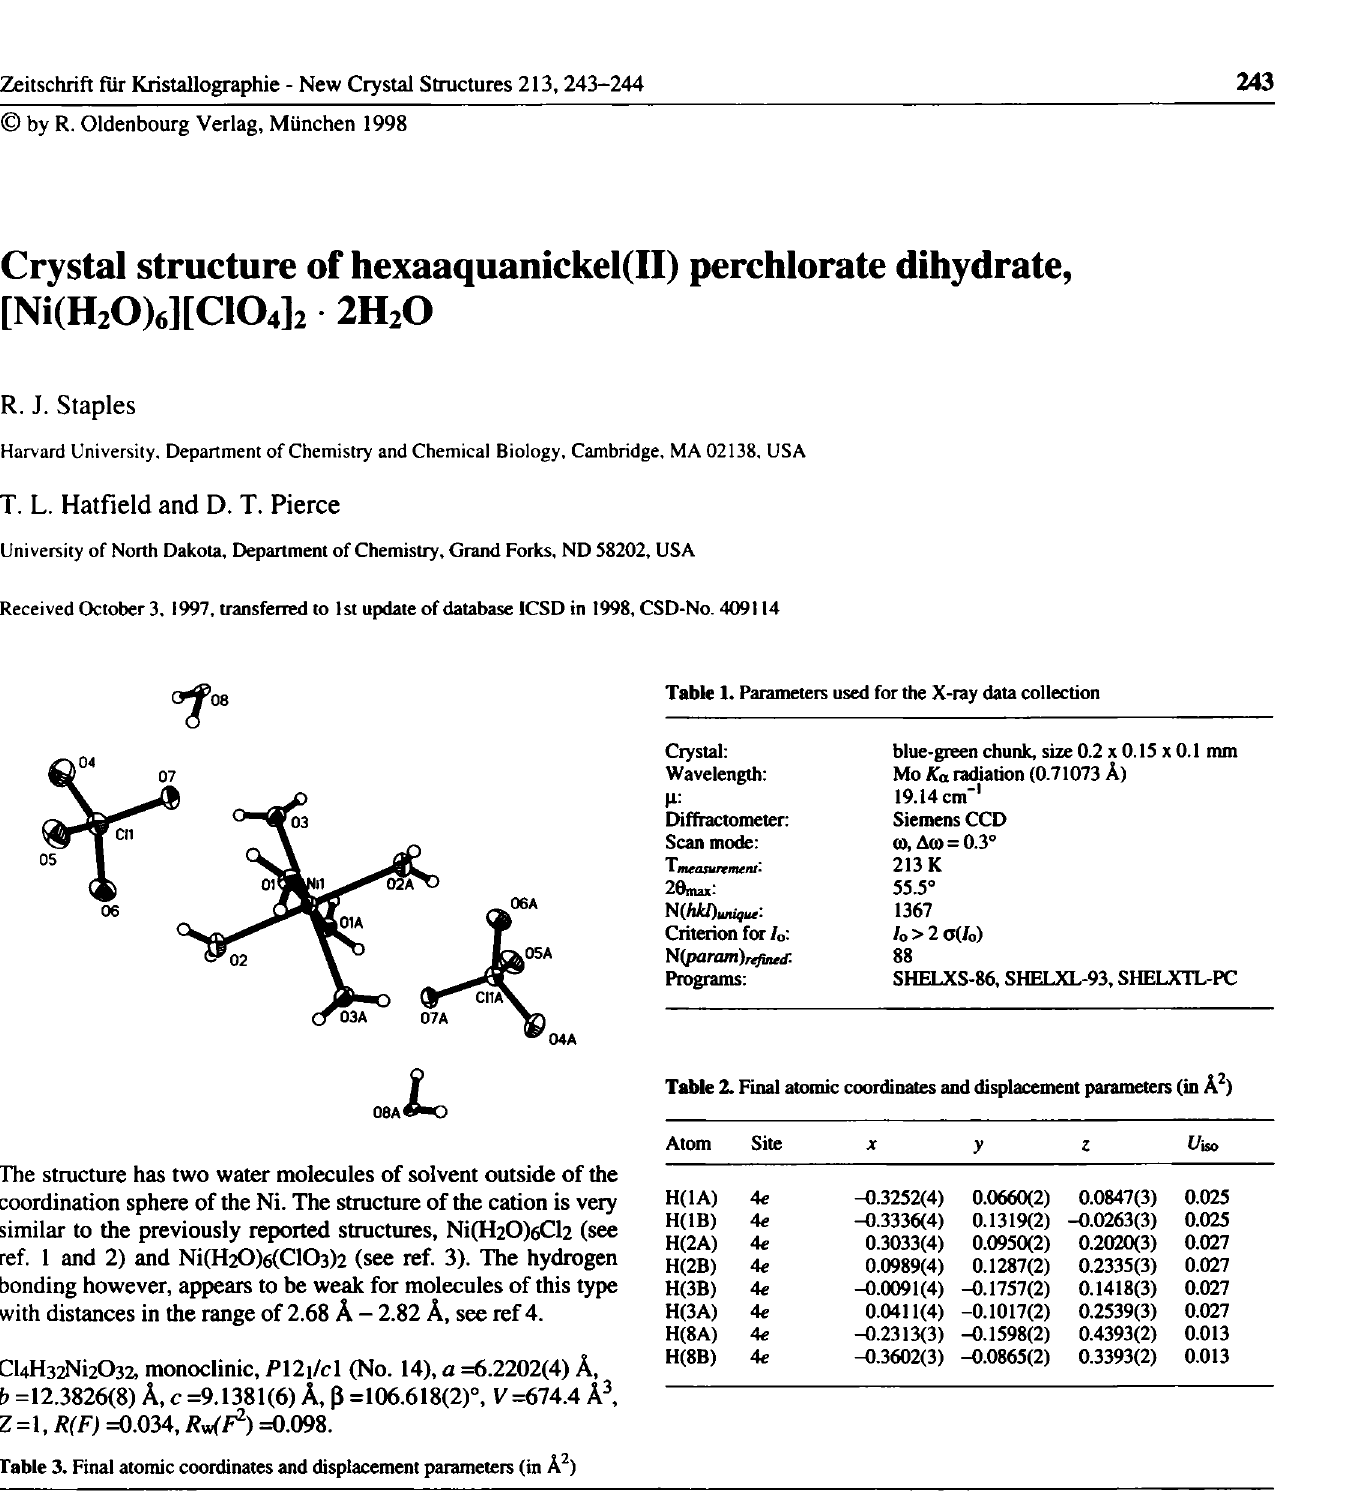
Table 3. Final atomic coordinates and displacement parameters (in Â^)